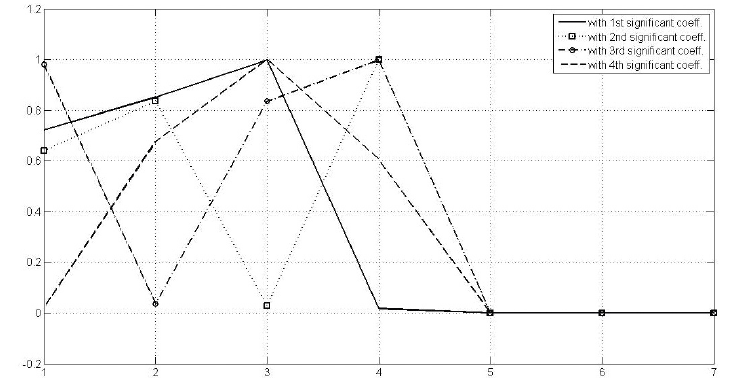
Figure 8. CCI plot generated by channel coefficients with estimated path